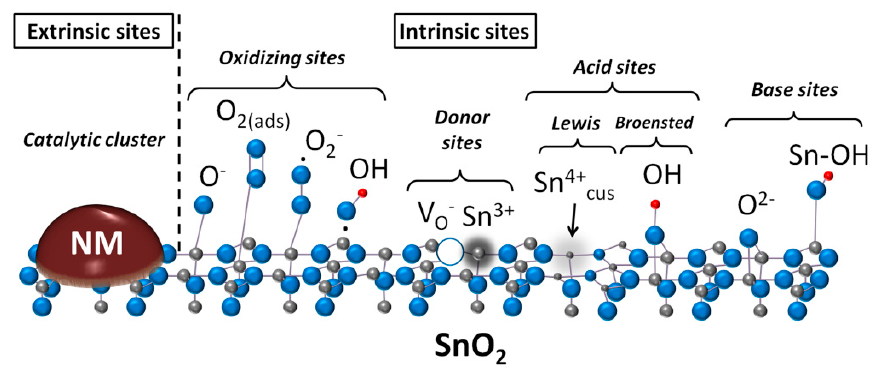
Figure 5. Types of active sites at the surface of tin oxide: noble metal cluster (NM), chemisorbed oxygen species (O 2(ads) , O 2 − , O − ), charged oxygen vacancies (V O − ), partially reduced cations (Sn 3+ ), coordinately unsaturated cations (Sn 4+cus ), hydroxyl species (OH, Sn-OH), surface oxygen anions (O 2 − ). Adapted with permission from ref. [79]. Copyright 2014 American Chemical Society.